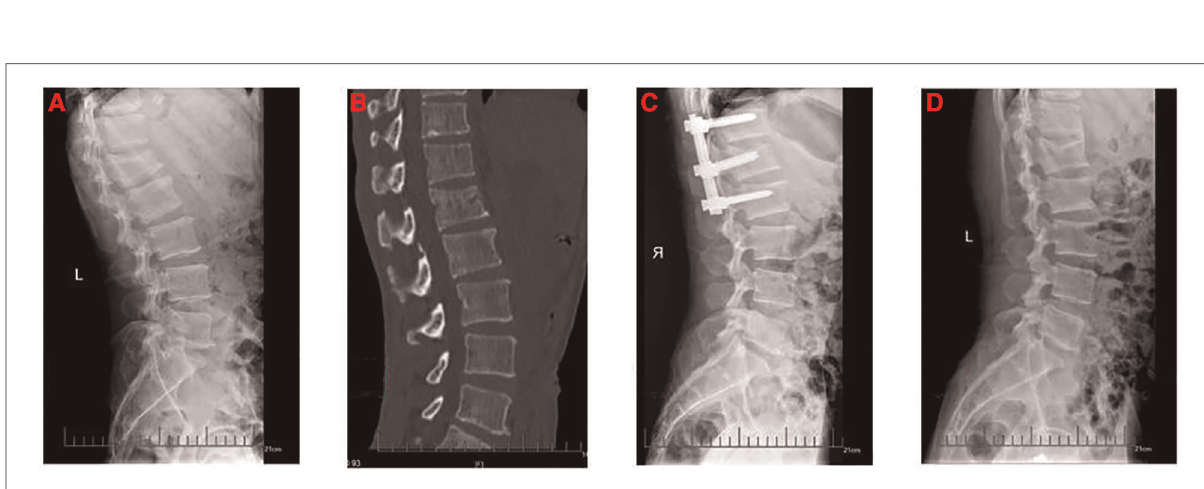
FIGURE 2 The preoperative and postoperative radiographs of six-pedicle screws fi xation with long intermediate pedicle screws group. ( A ) Preoperative lateral x-ray. ( B ) Preoperative lateral computed tomography. ( C ) Lateral x-ray 1 month after surgery. ( D ) Lateral x-ray at fi nal